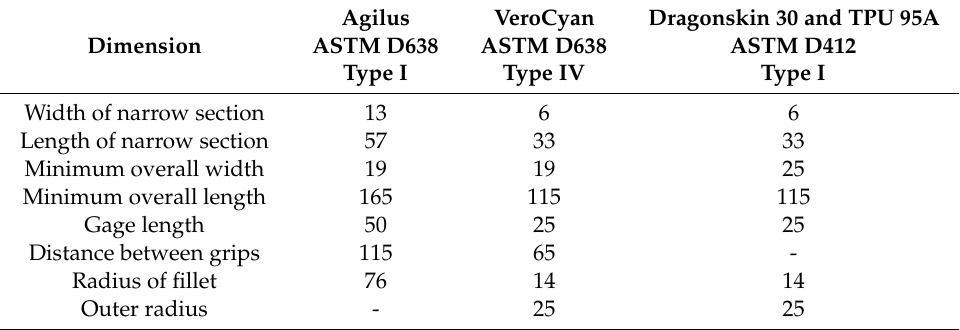
Table 2. Specimen dimensions (units: